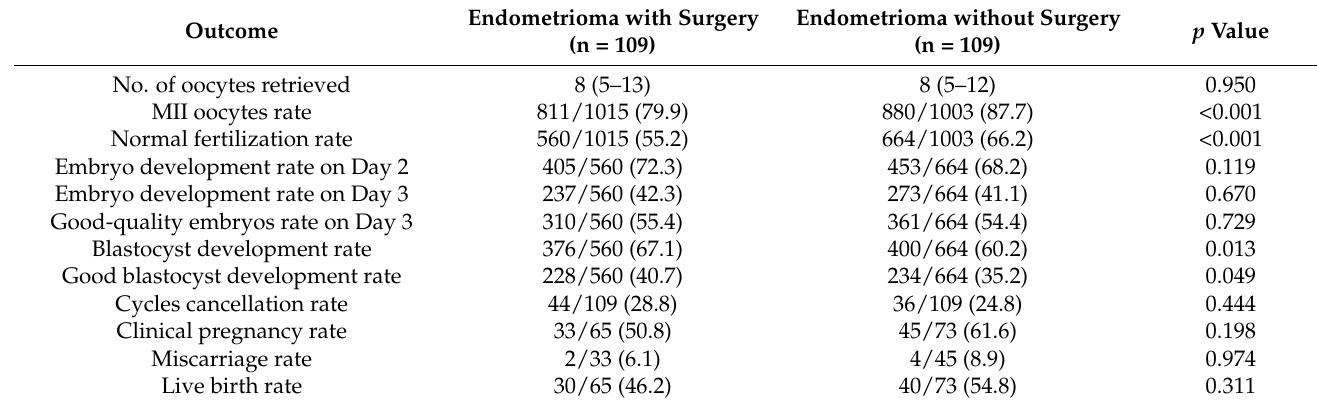
Table 4. Outcomes of the endometrioma women with and without surgery after